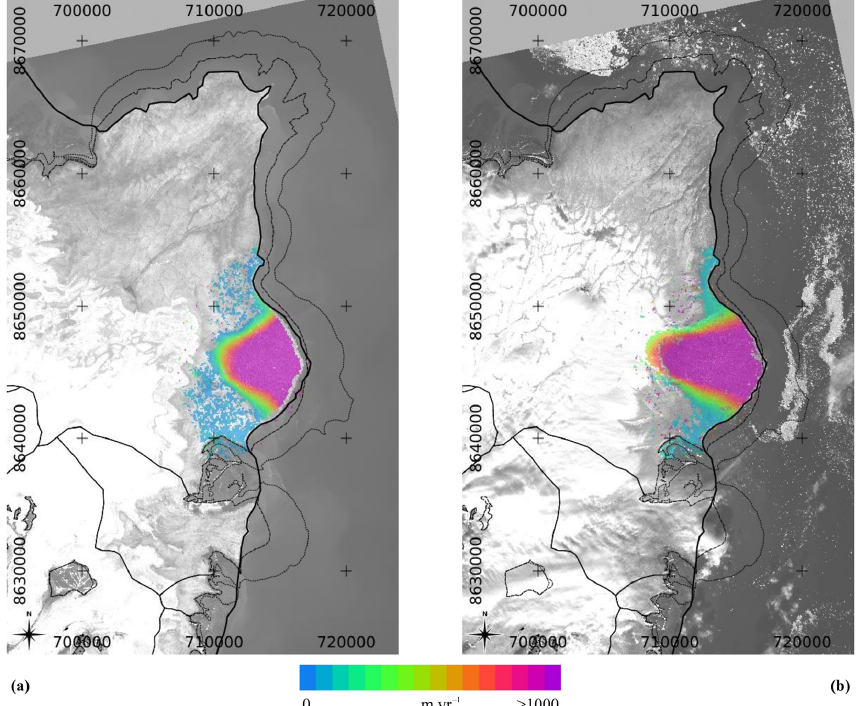
Figure 6. Ice surface velocity maps from Landsat 8 data of (a) 07/08/2014 and 25 August 2014 and (b) 19 August 2015 and 18 Septem- ber 2015. Image background is from the respective first scene. The coastal outline in 2015 (continuous line) is shown along with glaciers inventories of 1971 (dotted line) and 2006–2007 (RGI 5.0, dashed